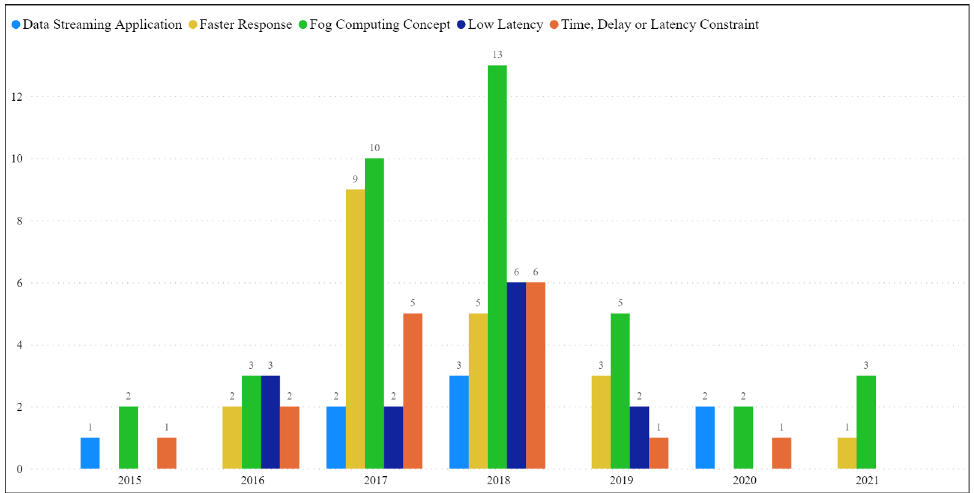
Figure 6. Publications separated by year and